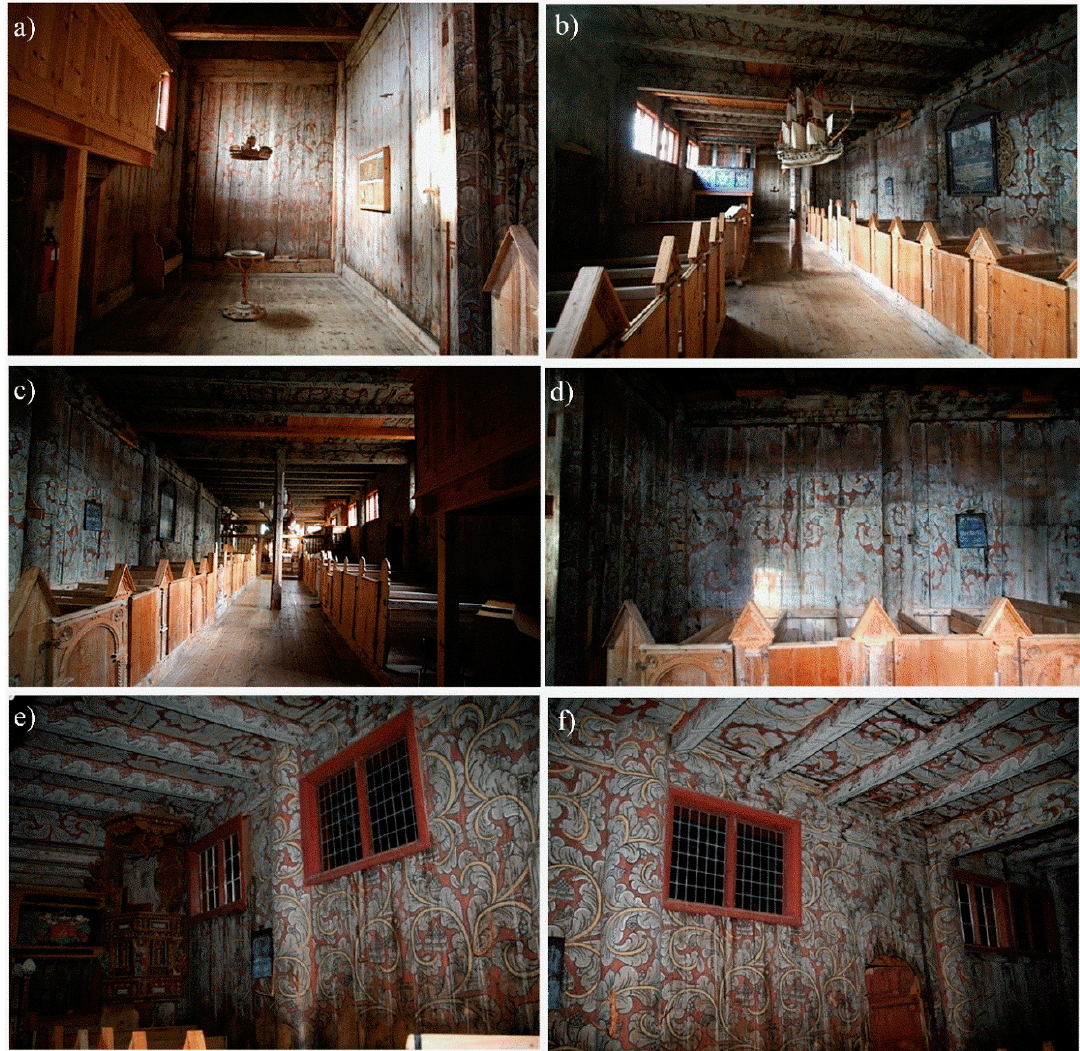
Figure 3. Overview of Kvernes stave church. Photos © NIKU 2011. ( a ) Baptistery, towards west; ( b ) nave looking west; ( c ) nave looking east; ( d ) north wall of nave (western part); ( e ) south wall of nave (eastern part); ( f ) south wall of nave (central part). Date: 3 March 2011.